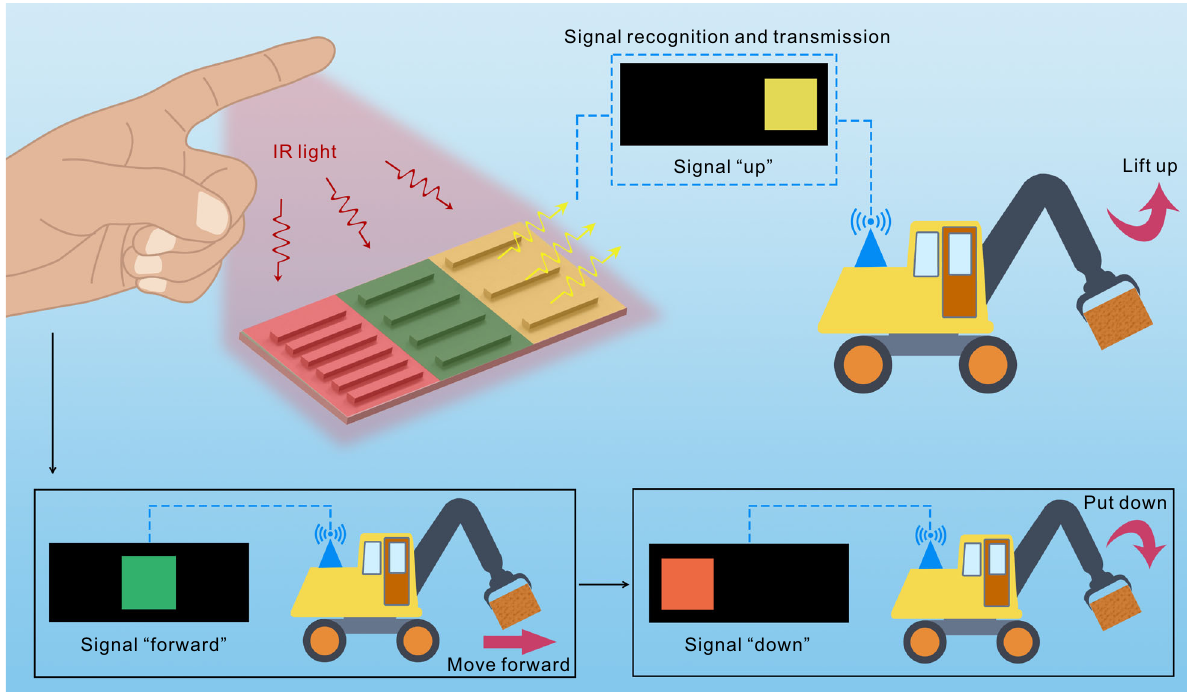
Fig. 1 Schematic illustration of the noncontact HMI based on hand-responsive IR structural color. The IR radiation from a fi nger at a speci fi c position can selectively interact with speci fi c metallic grating by diffraction. The diffracted IR radiation from the speci fi c grating can be detected as speci fi c IR structural color and then recognized as the corresponding command to control the action of a robot vehicle. With the movement of the fi nger, different IR structural colors can be generated, which can be recognized as different commands to control the robot